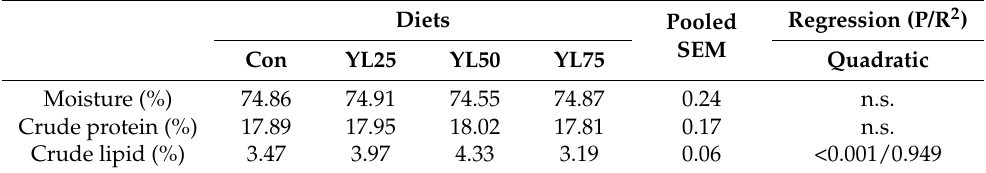
Table 2. Effects of dietary YL on flesh composition of juvenile largemouth bass fed the experimental diets for 28 days